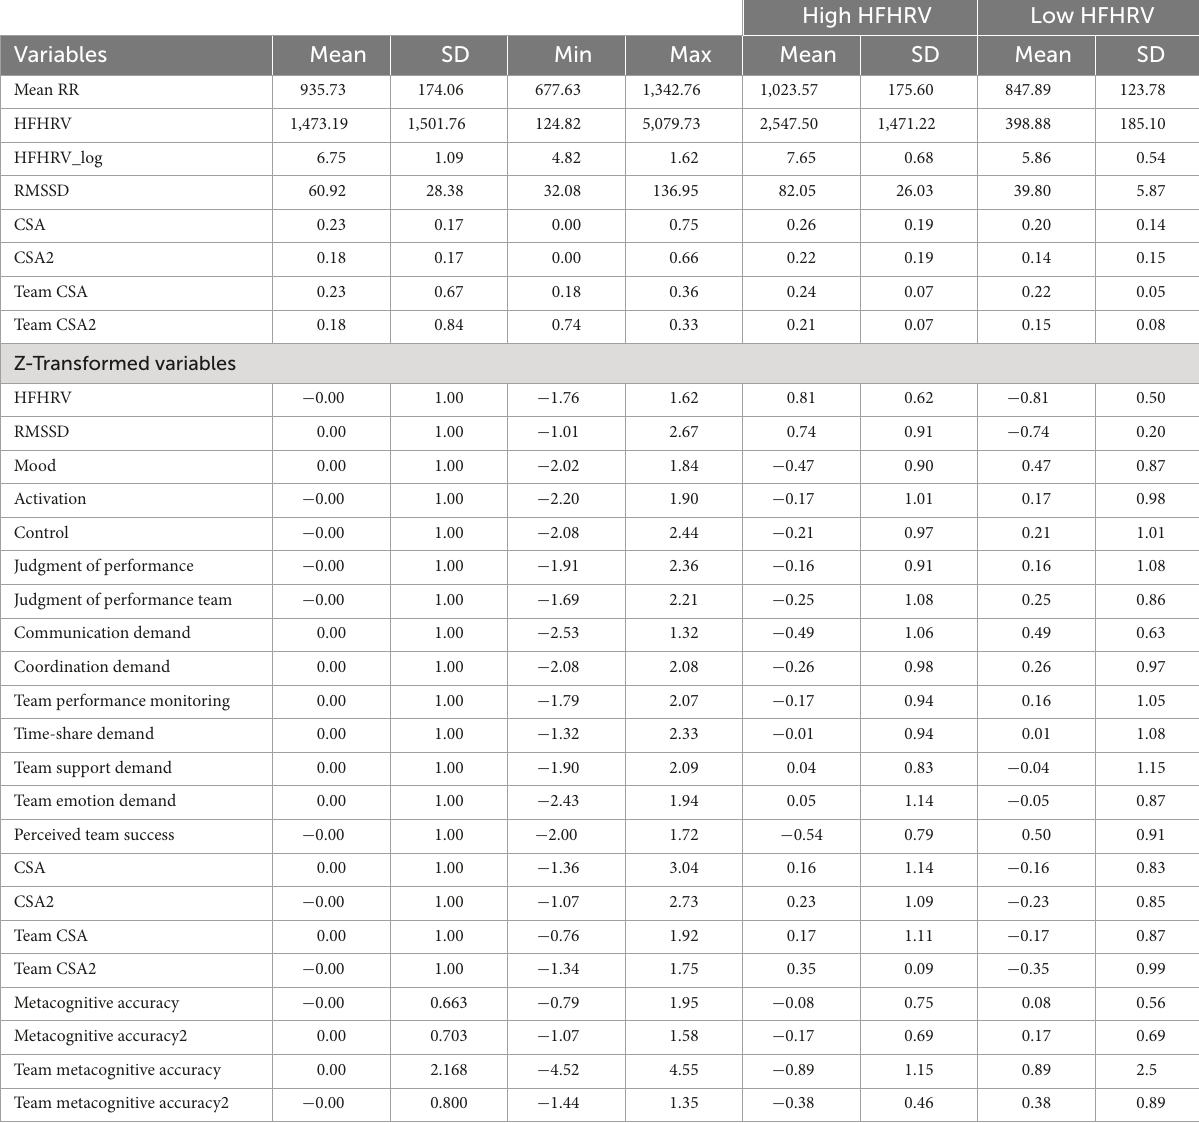
High HFHRV Low HFHRV